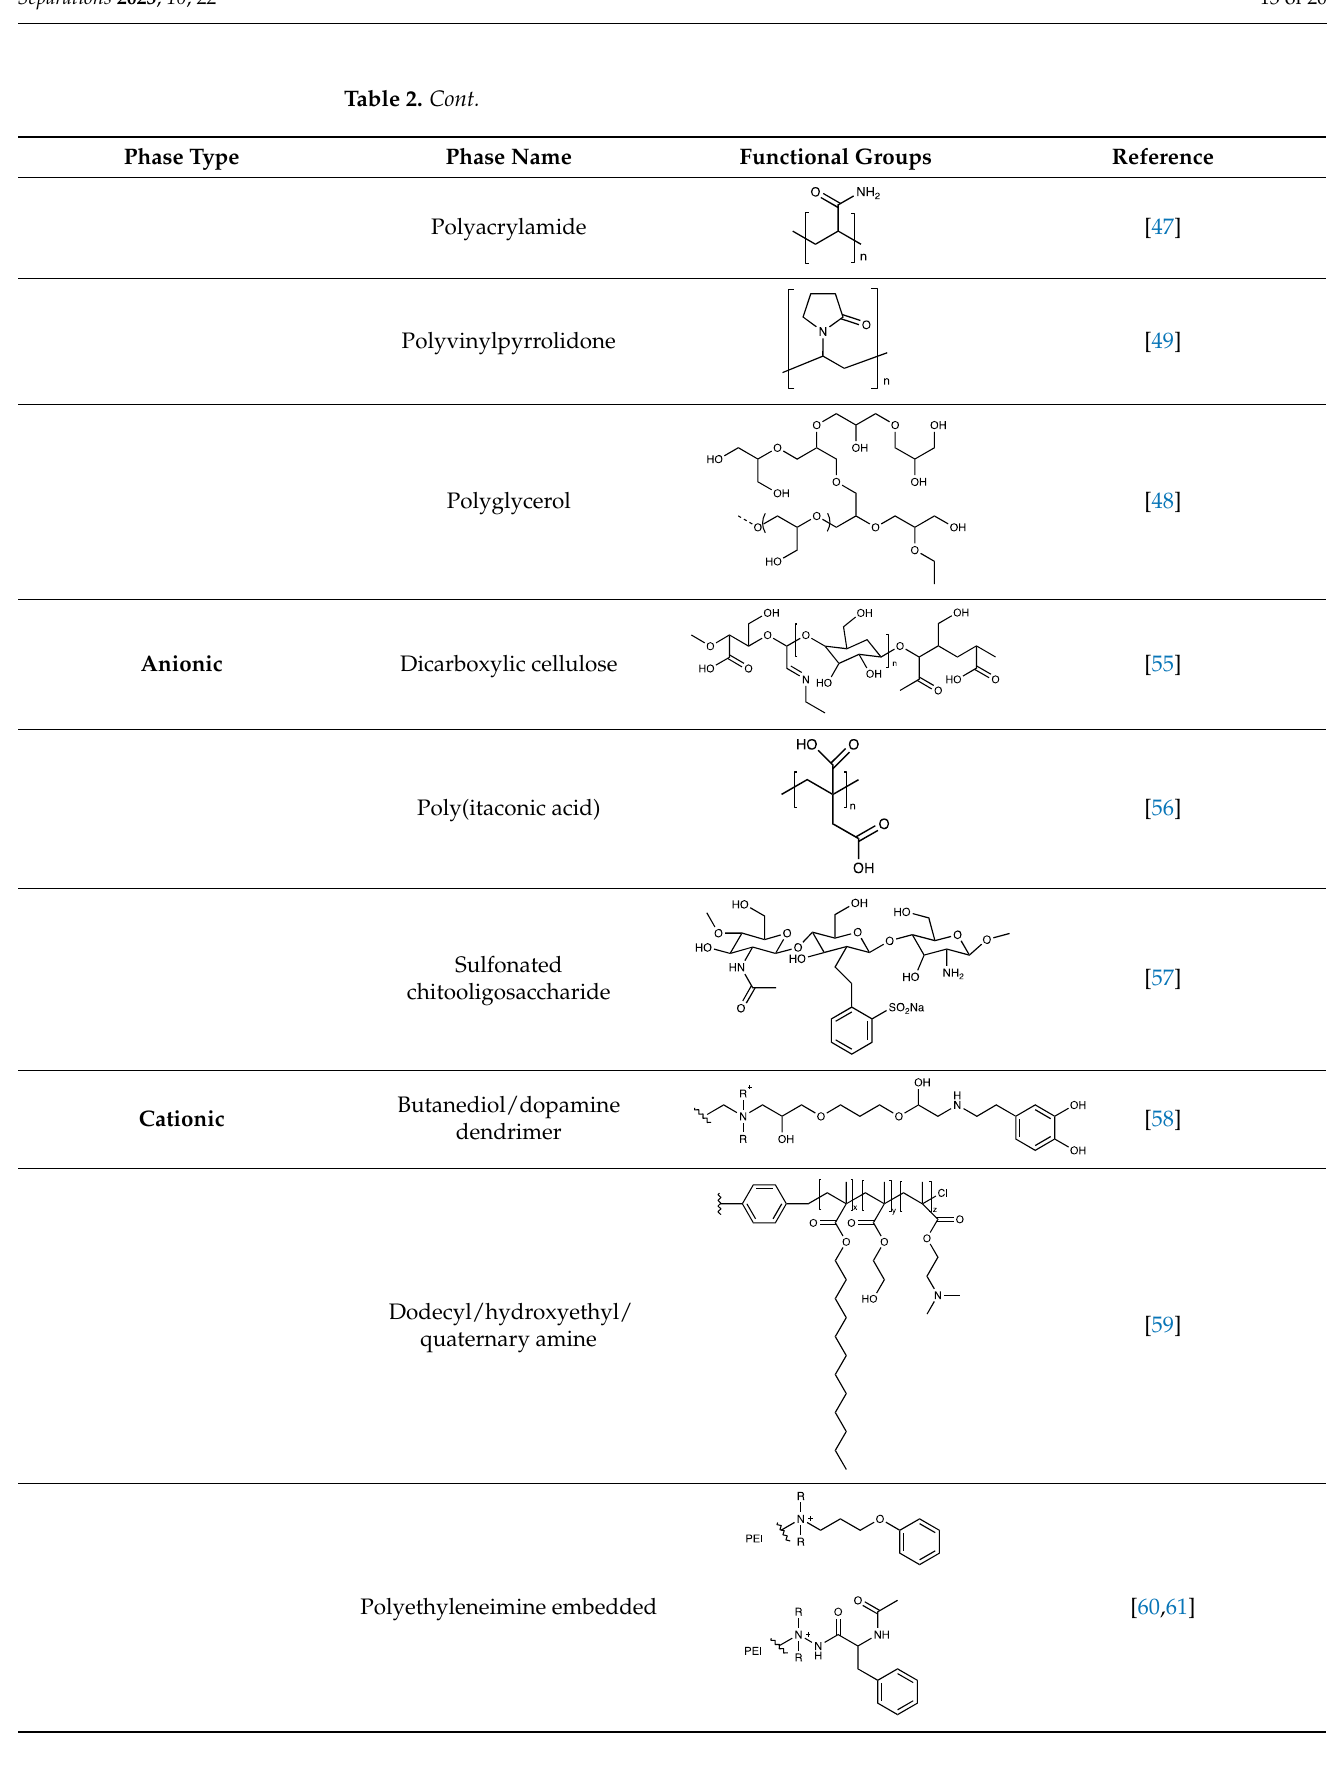
Table 2. Non-commercial stationary phases (in alphabetical order).